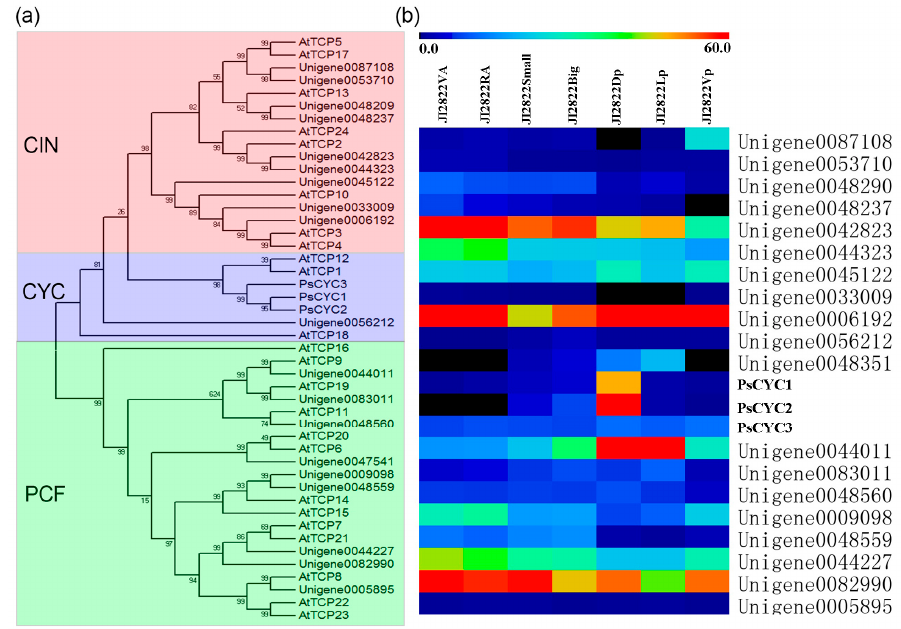
Figure 4. A Neighbor-joining consensus tree and the expression patterns of TCP genes in pea. unrooted protein tree for the TCP proteins using MEGA 5.0.1. The tree summarizes the evolutionary relationships among the 24 AtTCPs and 22 PsTCPs. Bootstrap values are denoted above the nodes. ( b ) The expression patterns of the TCP genes among different organs in pea. VA, Vegetative shoot apices; RA, Reproductive shoot apices; Small, 2-mm small buds; Big, 5-mm big buds; Dp, Dorsal petals; Lp, Lateral petals; Vp, Ventral